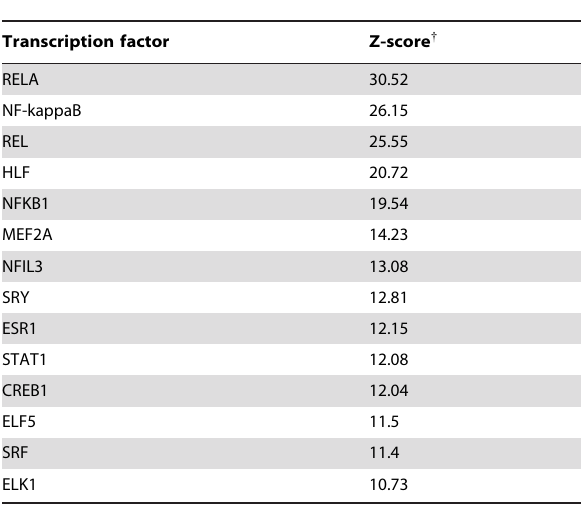
Table 2. Transcription factor enrichment of highly upregulated genes in